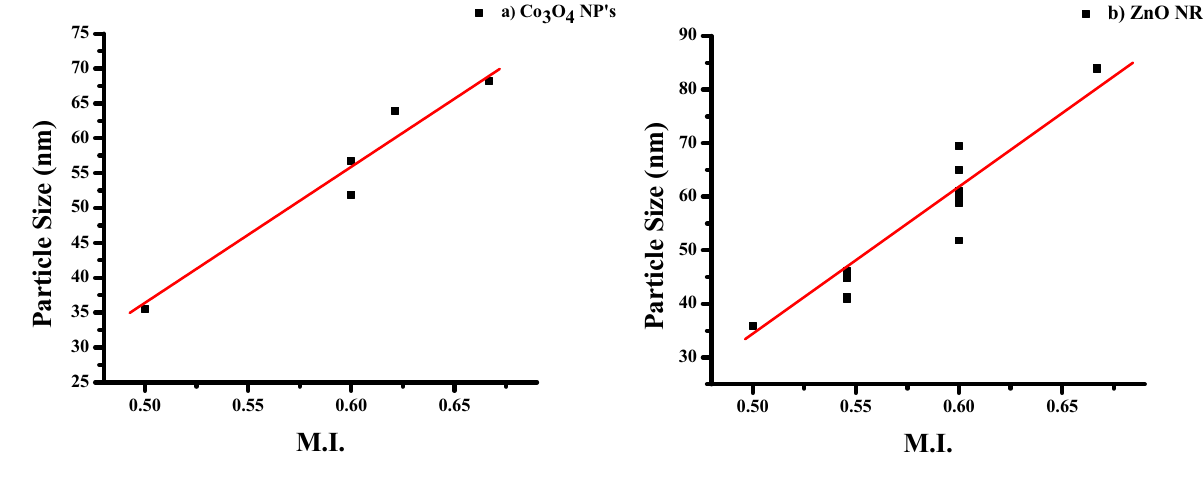
Figure 3. Morphological Index versus particle size of ( a ) Co 3 O 4 NPs and ( b ) ZnO NRs.